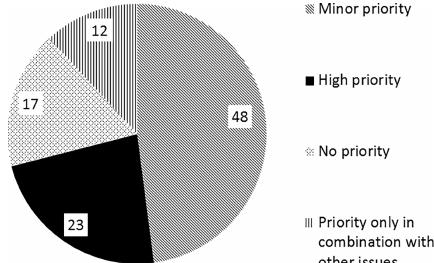
Figure 2. What priority has climate change in your region (survey municipality mayors, percentage of N =